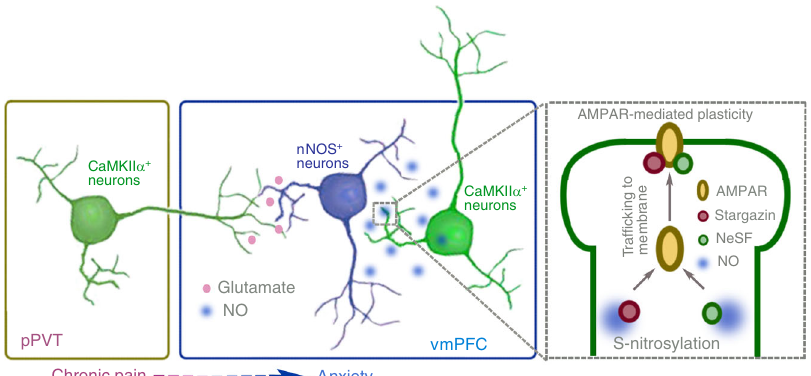
Fig. 9 A model diagram illustrating the role of vmPFC nNOS-expressing neurons in chronic pain-induced anxiety. During chronic pain, vmPFC nNOS- expressing neurons are stimulated by glutamatergic inputs from pPVT CaMKII α + pyramidal neurons. Activated nNOS-expressing neurons produce diffusing NO and cause the S-nitrosylation of AMPAR-interacting proteins in CaMKII α + pyramidal neurons, promoting AMPAR traf fi cking to the plasma membrane. Consequently, enhanced AMPAR function in vmPFC CaMKII α + pyramidal neurons leads to anxiety-related